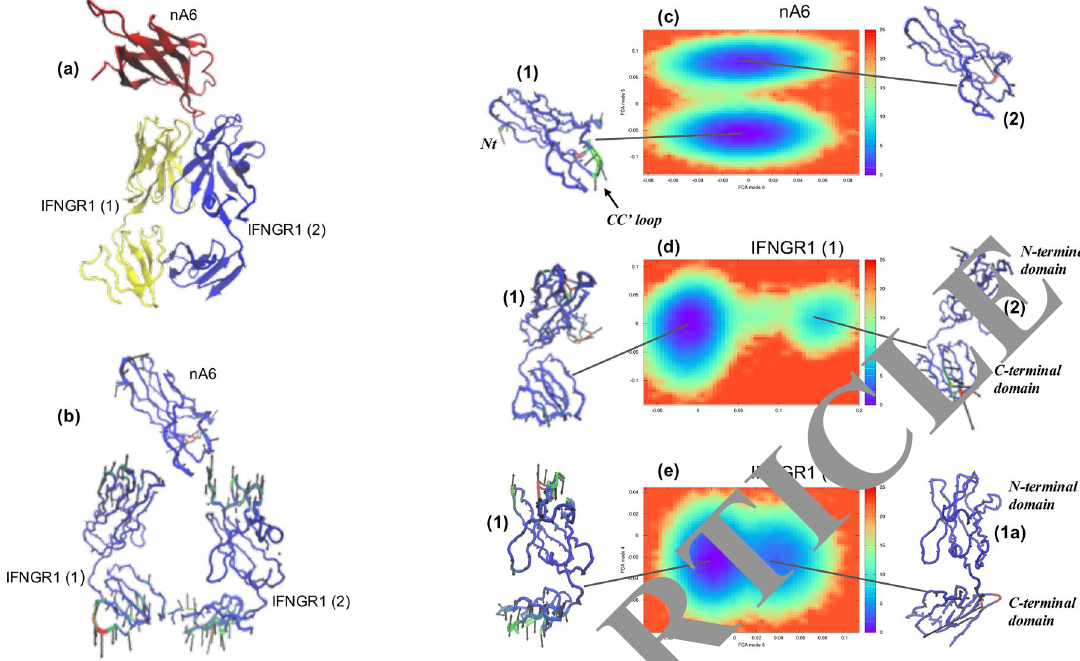
Figure 13. ( a ) 3-D representation of the crystal structure of the antibody nA6 bound to the receptors IFNGR1 (1) and IFNGR1 (2) and ( b ) the corresponding dynamics of the principal conformational states of the individual molecules forming the receptor complex from the FCA of the MD simulations in water. Regions in red are more mobile and regions colored blue in the depiction have less mobility. The arrows show the direction of motion in the individual molecules. The free energy surface derived from the FCA of the MD trajectories of ( c ) the antibody nA6, ( d ) IFNGR1 (1), and ( e ) IFNGR1 (2) of the antibody receptor complex in a mixed water–ethanol solvent and the corresponding Ca- representation of each conformation illustrating the dominant motion within the minimum of the energy